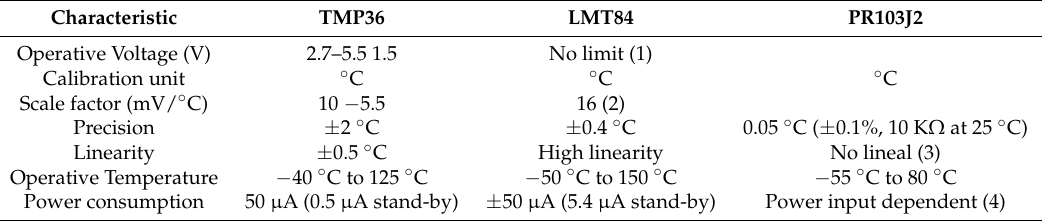
Table 1. Comparing performance characteristics from all tested temperature